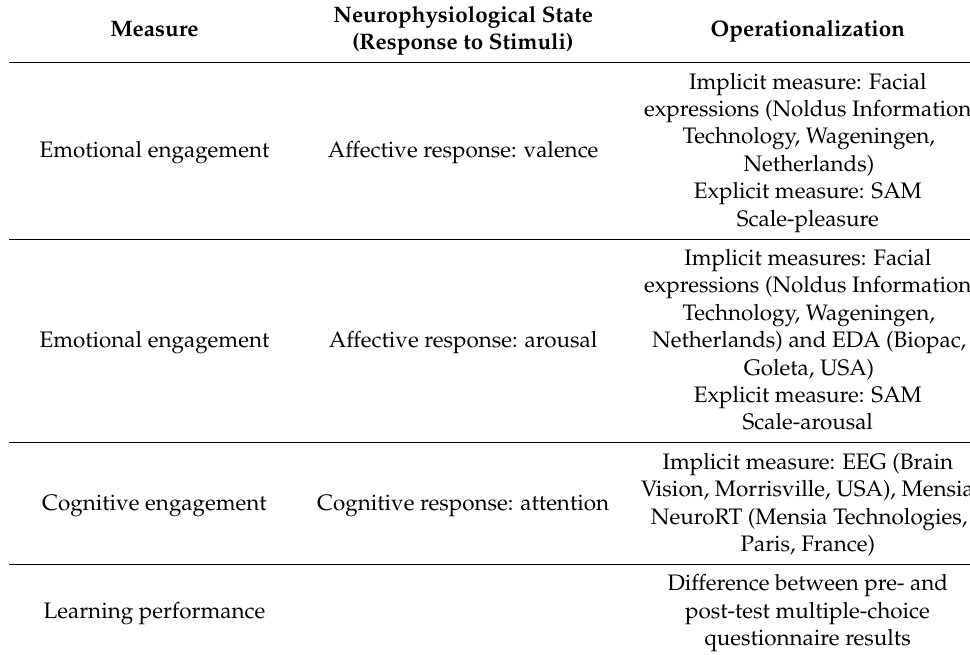
Table 2. Operationalization of the